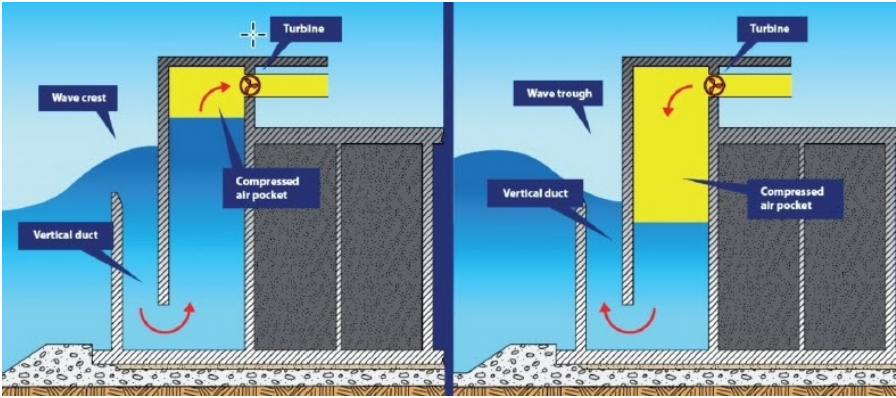
Figure 13. Working principle of REWEC3 [55].